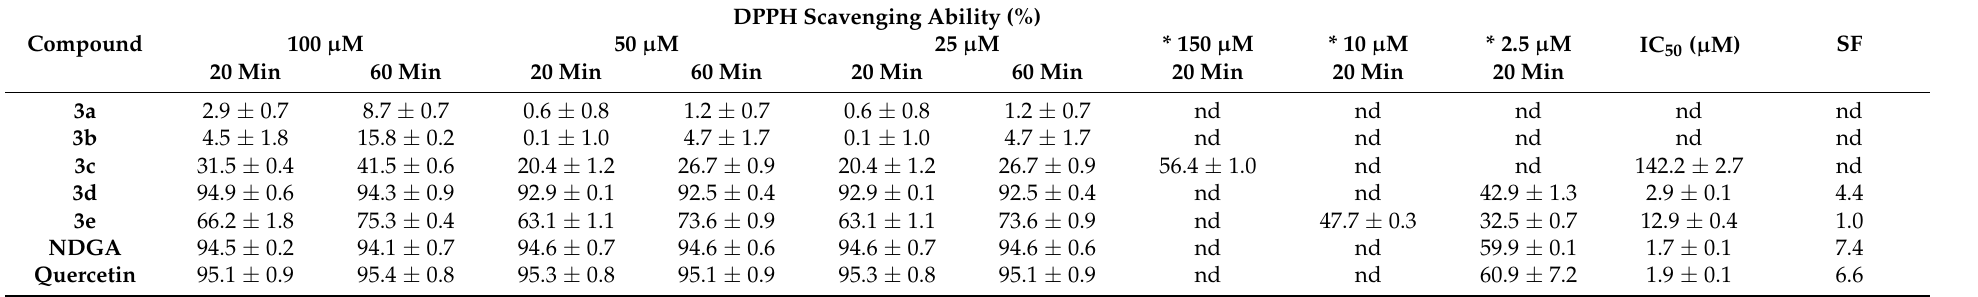
Table 2. In vitro DPPH antioxidant activity of products 3 and reference compounds (%, IC 50 and SF values).